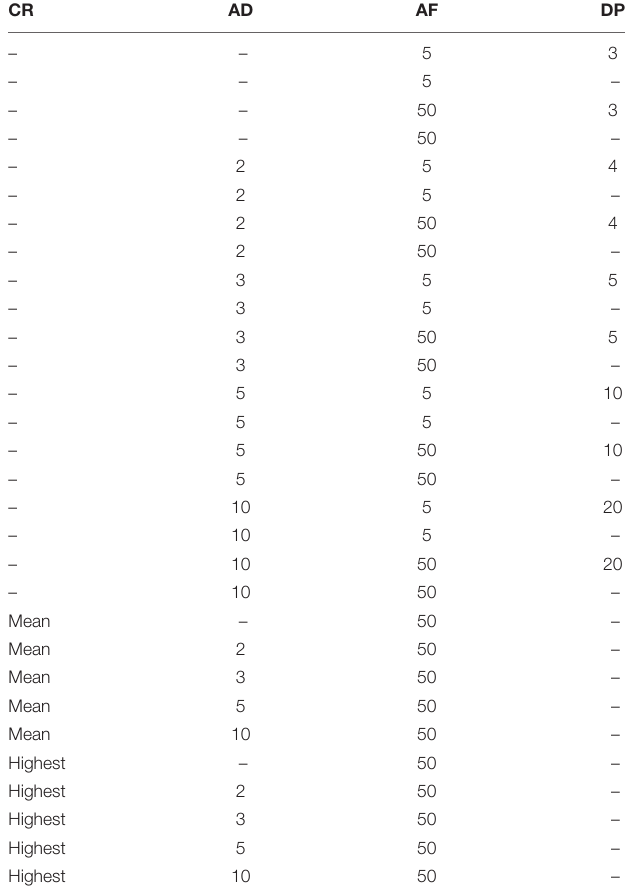
TABLE 1 | Patterns of filters tested on the Polizzello dataset. CR AD AF DP